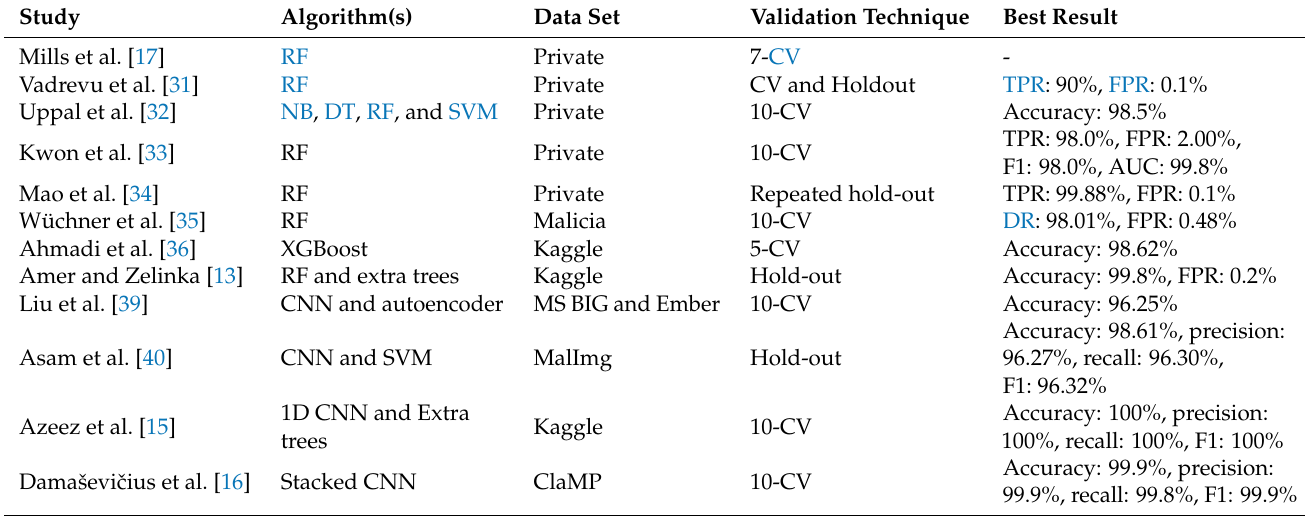
Table 1. Summarization of the existing PE malware